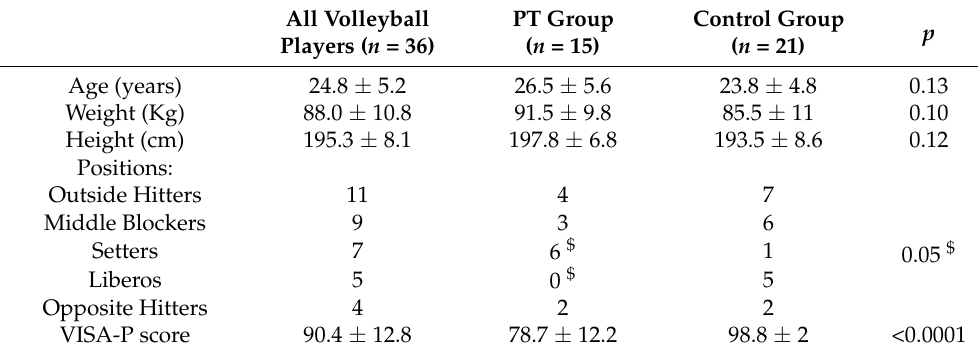
Table 1. Description and comparison of professional volleyball players according to the presence or the absence of patellar